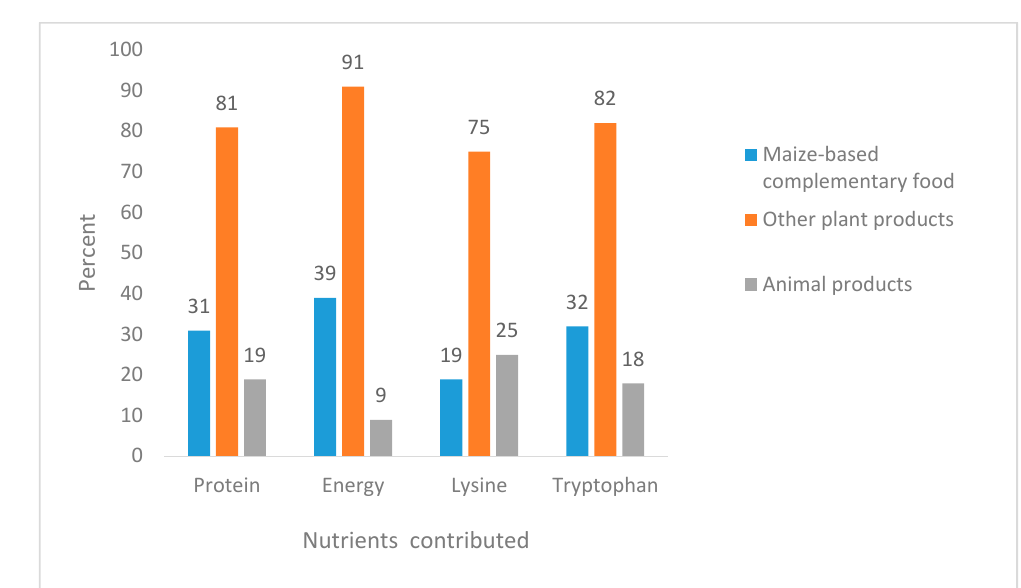
Figure 3 . The contribution of plant- and animal-based complementary foods to nutrient intakes of children. Table 3 . Dietary protein and essential amino acids intake of children 1 .